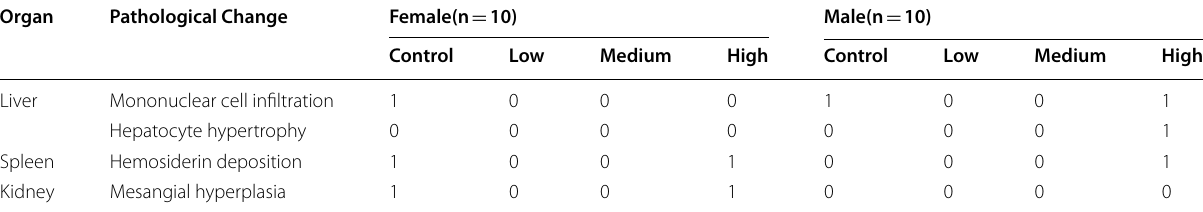
Table 1 Histopathology results of rats exposed to maleic acid polymer scale inhibitor Organ Values indicate the number of rats with pathological changes in the liver, spleen and kidney in the control and dosed groups. There were no pathological changes in the low- and medium-dose groups, and no pathological changes in other organs